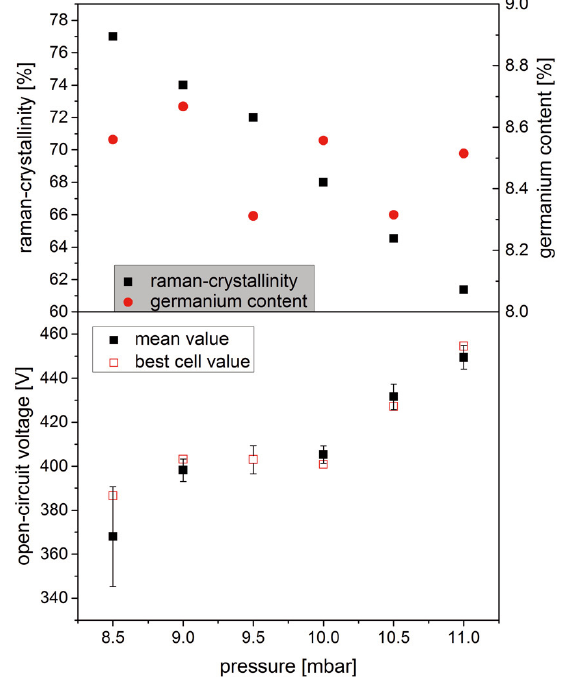
Fig. 4. Raman crystallinity, germanium content and V oc values of single µ c-SiGe:H cells in relation to the intrinsic layer process pressure.